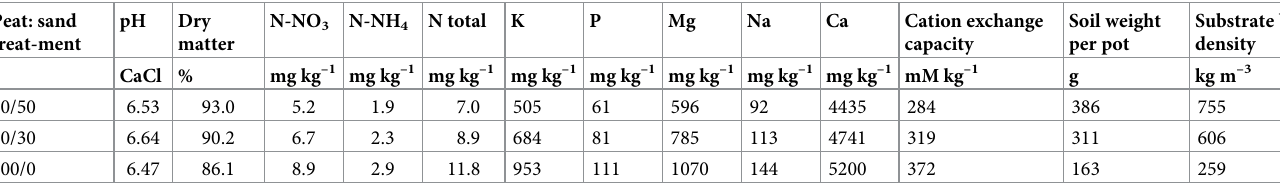
spores per g at a dose of 0.015 g cm 3 of the substrate. The AMF + AZ treatment contained AMF and A . brasilense (10 8 CFU in sterile 1XPBS). Seeds were soaked for 30 min. and were used for tomato inoculation with A . brasilense . S . tamanrassetensis was grown in a yeast-malt Table 1. Selected substrate parameters at the beginning of the experiment. Peat: sand treat-ment